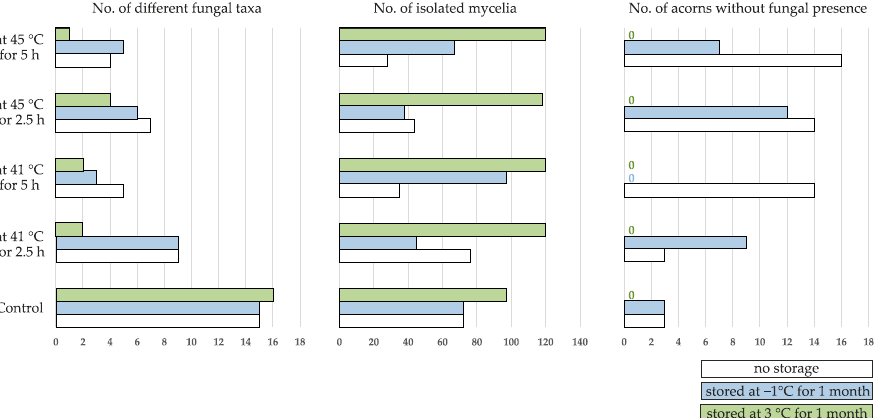
Figure 4. Number of obtained fungal taxa, isolated mycelia, and acorns without fungal growth in Quercus robur acorn groups exposed to different thermotherapy treatment and storage conditions.